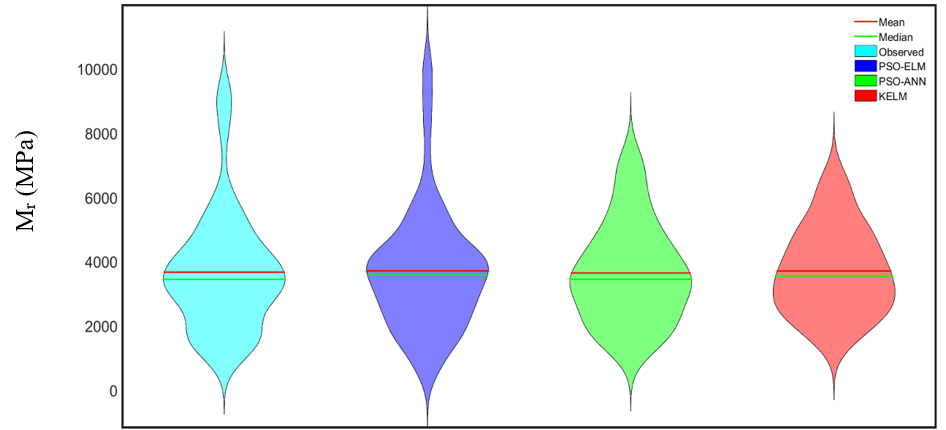
Figure 5. Violin testing plot for the three investigated models.